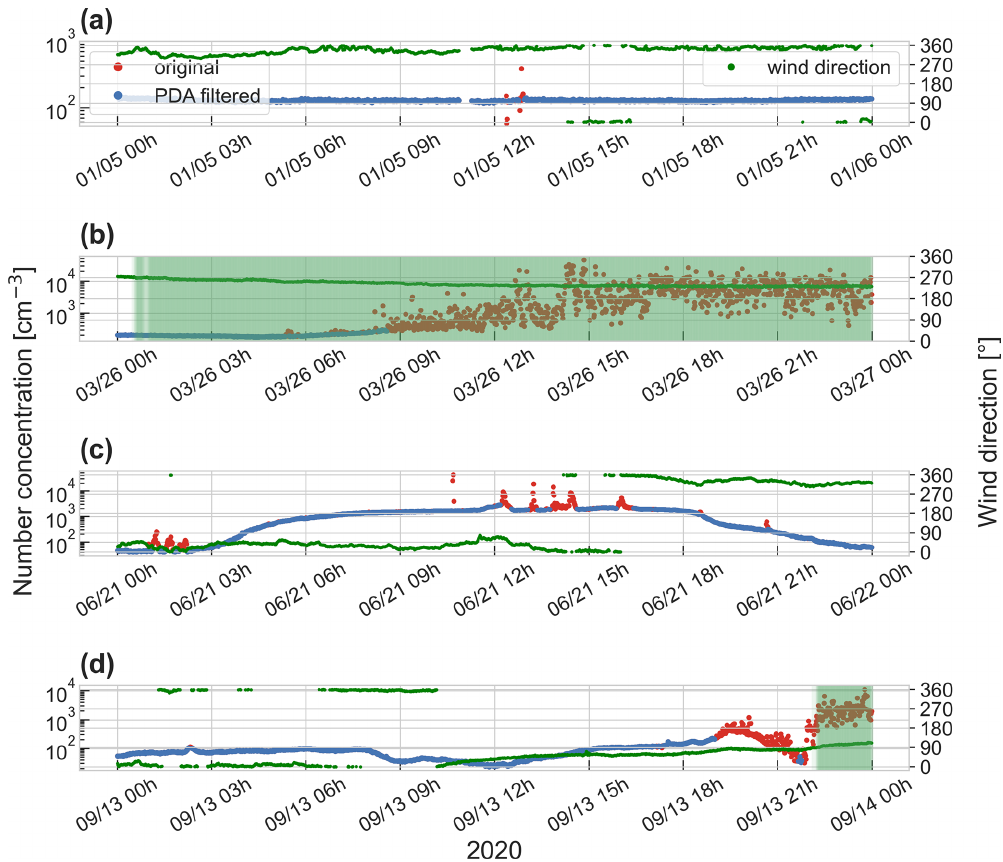
Figure 5. Performance test of the PDA method in four different situations. (a) Under overall stable conditions, (b) transition from clean to polluted conditions, (c) a natural increase in particle number concentration due to new particle formation, and (d) a natural decrease in particle number concentration due to a precipitation event (freezing rain) in the morning (from 09:00 to 12:00UTC). Green shaded areas indicate where the wind filter would flag data as polluted. Green points show the wind direction, and red points show the raw particle number concentration, overlaid with the cleaned data points in